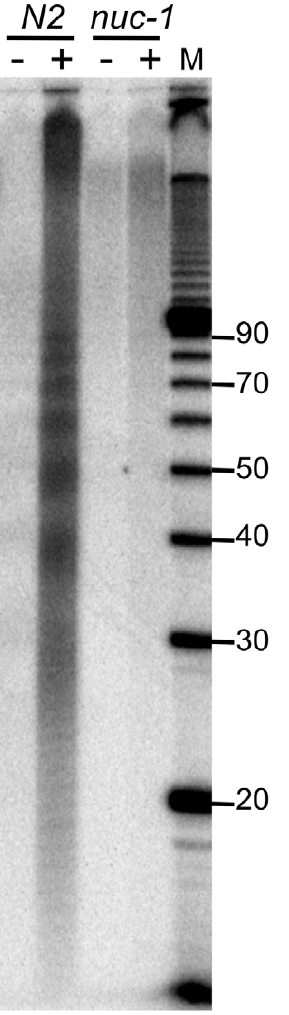
Figure 3. Small DNA pieces correlate with TUNEL negative fragments. Embryos were isolated from gravid adults, of N2 or nuc- 1(e1392) genotype, and nucleic acid isolated using the ‘‘total RNA’’ protocol. A representative PhosphorImage (n=7) shows DNA pieces radiolabeled with TdT and a - 32 P-Cordycepin 5 9 triphosphate, before (-) or after ( + ) treatment with CIP. Positions of 10 bp DNA ladder (M) are labeled on the right.